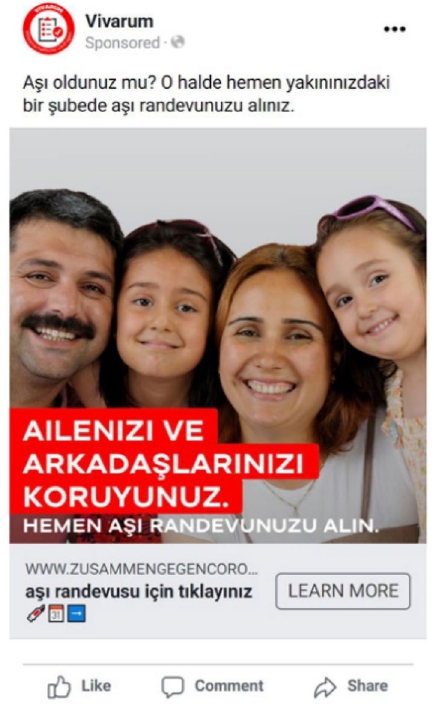
Figure 2. Example of Facebook advertisement used in the online COVID-19 vaccination campaign (in Turkish). Note: Vivarum Facebook Ad Manager, 2022; English Translation—Top: “Are you vaccinated yet? Now